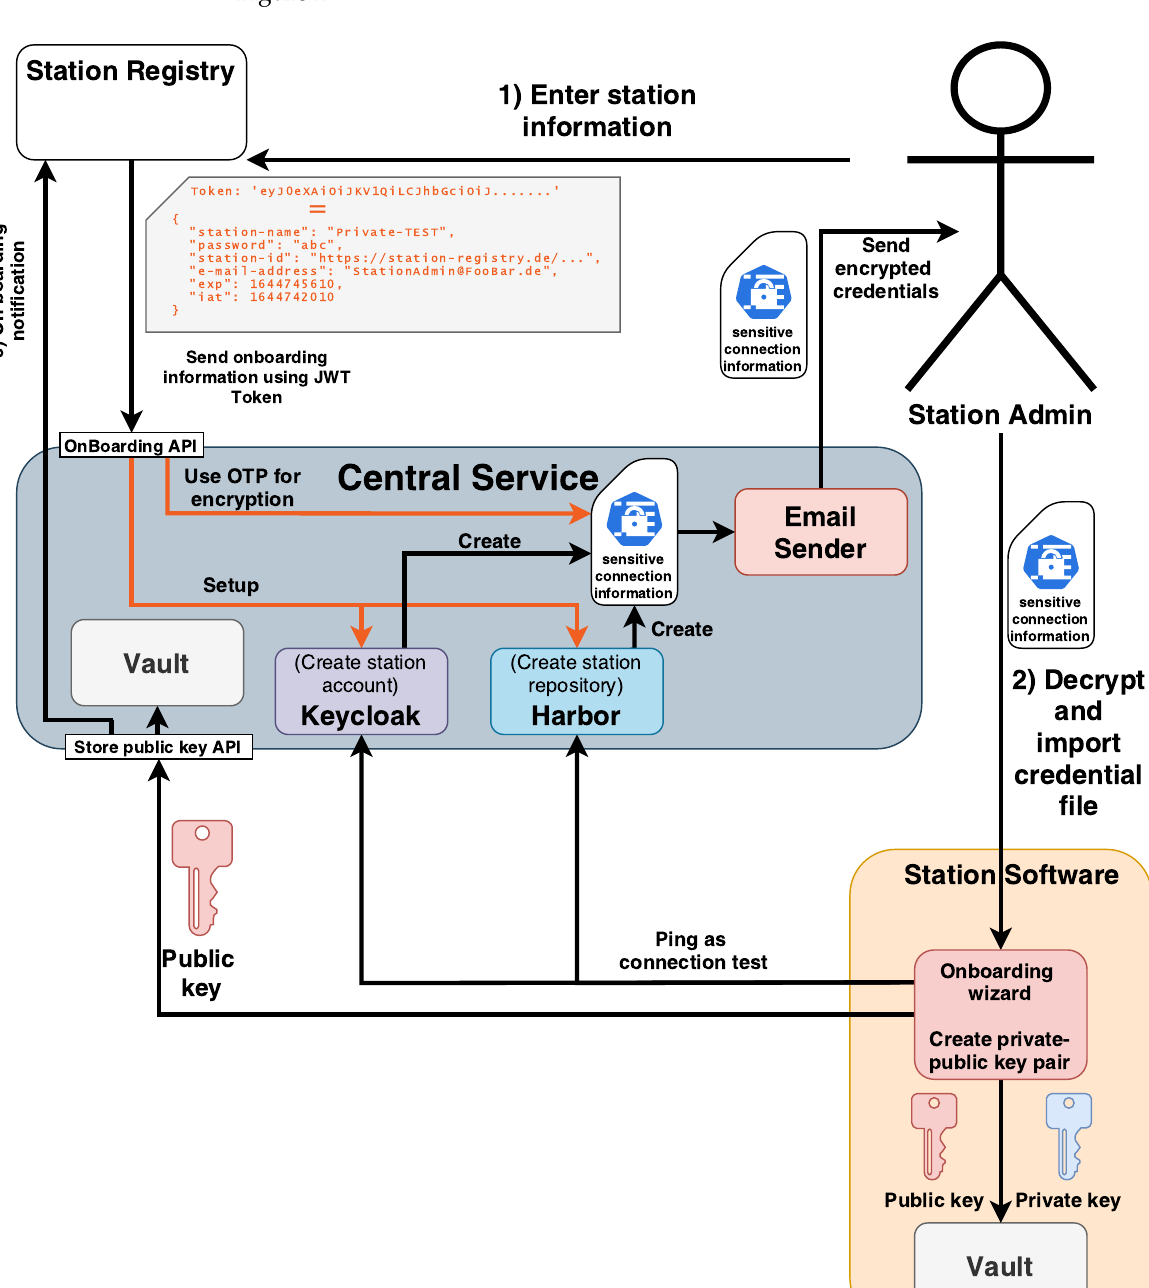
Figure 2. Overview of the on-boarding service and its interaction with the DA infrastructure. First, the responsible person (station admin) for the station has to provide (meta-) information about the prospective station. After the registration, the station registry triggers the on-boarding procedure in the CS. The output of this procedure is an encrypted file containing connection credentials for the station to communicate with the CS. For the encryption, the procedure uses the OTP priorly provided by the station admin. This file is sent via an email service. After receipt, the file can be decrypted using the OTP and on-boarding wizard for the station software. Using the wizard, the admin can create key pairs for future use in the DA infrastructure. The keys are send to the CS followed by a connection test